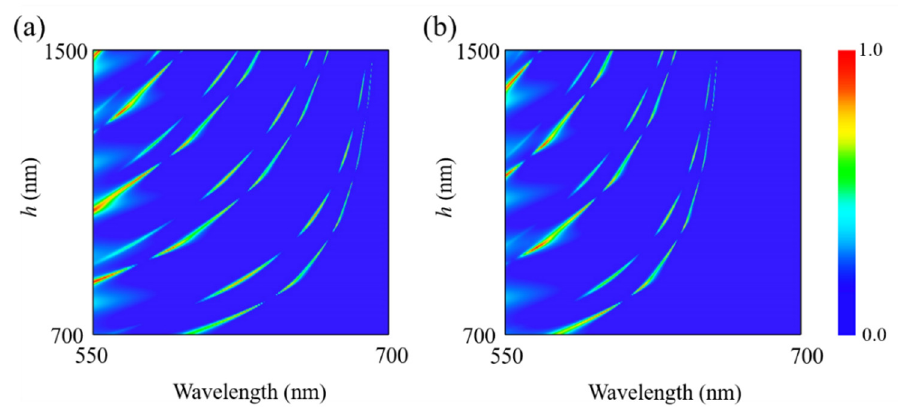
Figure 8. Absorption spectra of the proposed structure as a function of wavelength and the thickness of dielectric layer h for incident polarization along ( a ) [100] and ( b ) [001] crystalline directions of α -MoO 3 . p = 500 nm, w = 40 nm, and t = 105 nm.